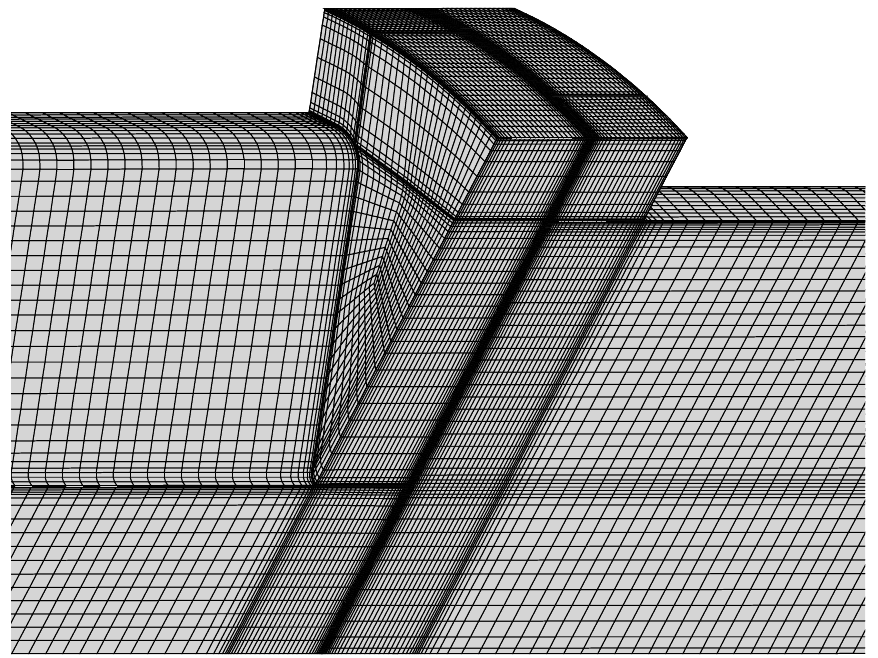
Figure 7. Mesh at the mid-chamber.